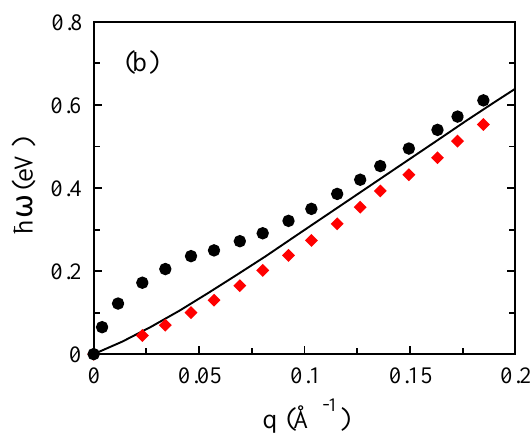
Figure 21. The optical (black dots) and acoustic plasmon modes (red diamond) of bilayer phosphorene that correspond to the peaks in the EEL functions in the upper panel for n = 3.2 × 10 13 cm − 2 ( E F = 0.05 eV) along the armchair direction. The black line shows the boundary of the electron-hole